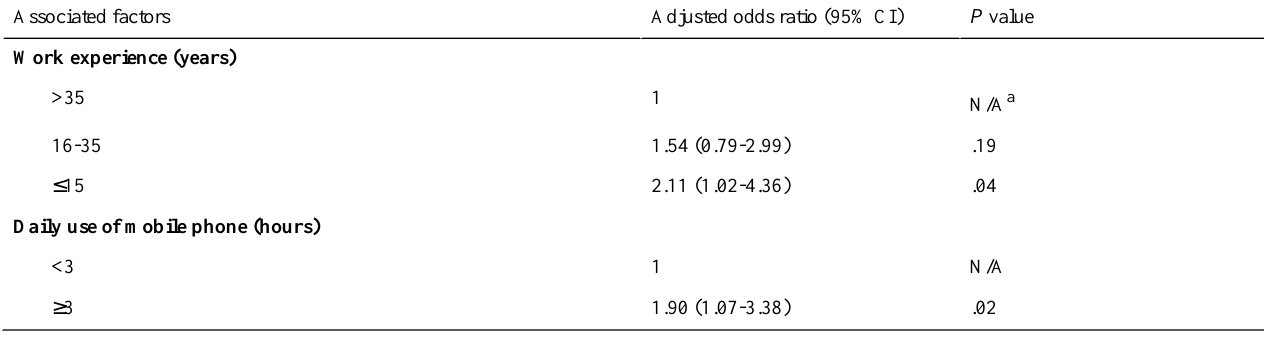
Table 2. Multivariate analysis of factors associated with work-related use of social networking site apps by primary care professionals.